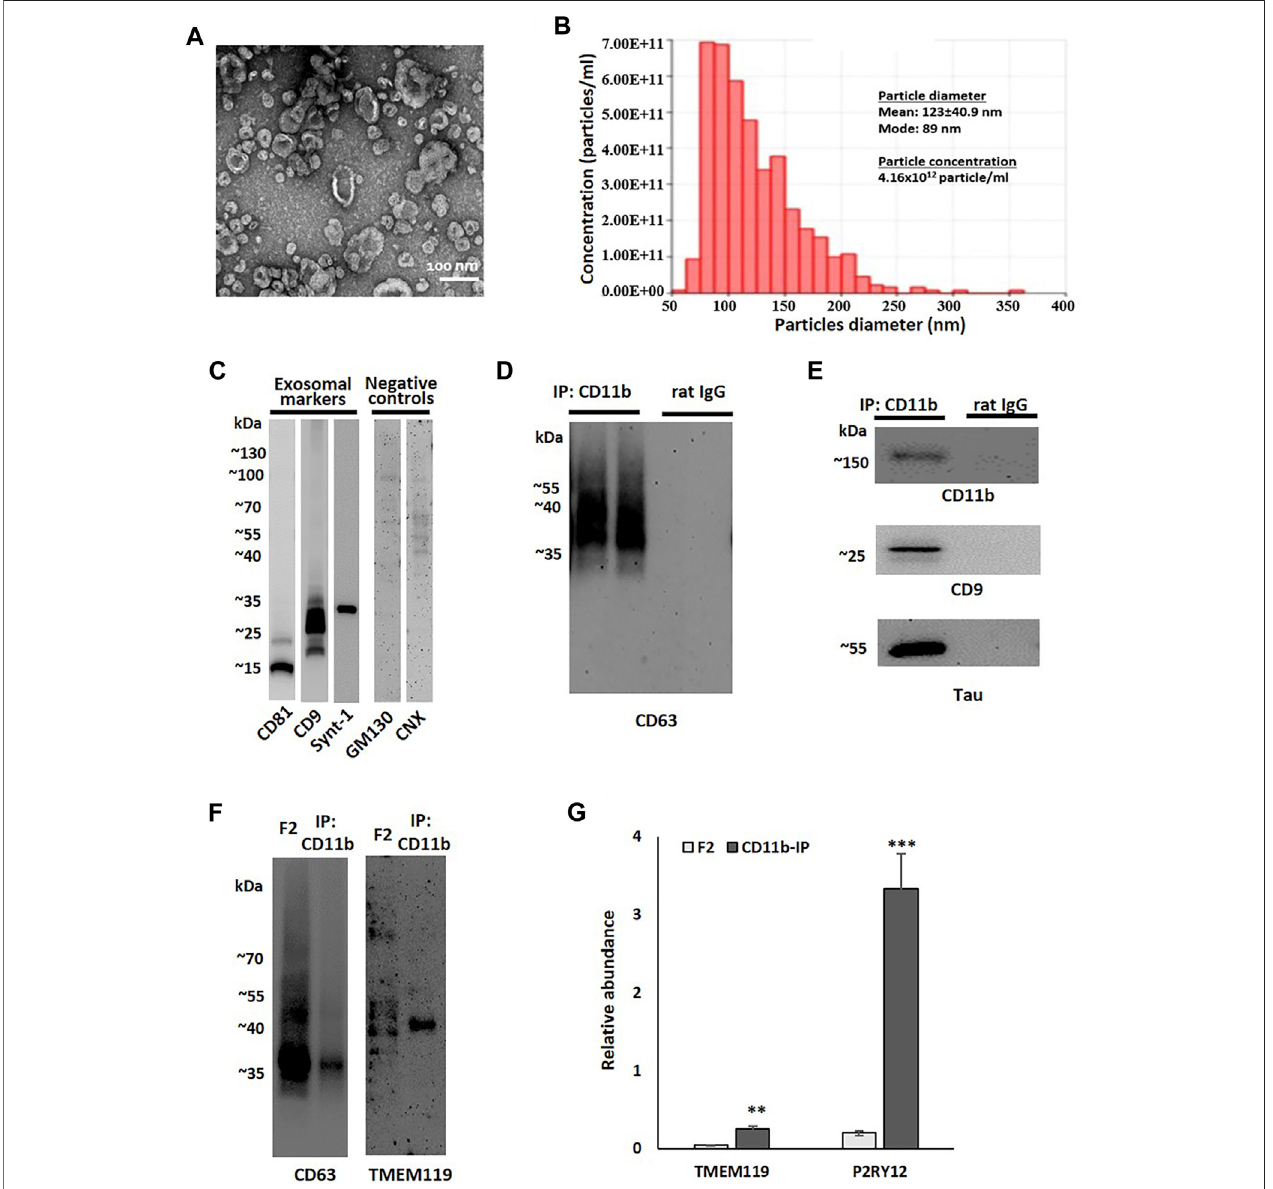
FIGURE1| Small EVfraction characterization and microglial EVpuri fi cation. (A) Representative transmission electron microscopy (TEM)image ofsmallEV fraction (F2) isolated from the human parietal cortex. (B) Tunable resistive pulse sensing (TRPS) analysis of the F2 fraction isolated from the human parietal cortex. (C) A representative image of immunoblot analysis of an F2 fraction using antibodies against exosomal markers (CD9, CD81, and syntenin-1) and negative control markers (GM130 and calnexin, CNX). (D) A representative image of immunoblot analysis of two immunoprecipitation (IP) samples pull-down either with antibodies against microglial marker CD11b or with corresponding isotype control antibodies (rat IgG2b). Membrane was probed with the exosomal marker CD63. (E) Immunoblotting of CD11b-IPsamplesand isotypecontrolsamplesprobed withantibodies against amicroglialmarker(CD11b),an exosomal marker(CD9),and tau. (F) Immunoblottingof the F2 fraction isolated from the human parietal cortex and corresponded CD11b-IP fraction with antibodies against the exosomal marker CD63 and the microglial markerTMEM119.ThesamplevolumewasequalbetweenCD63andTMEM119immunoblots. (G) Relativeabundancesofmicroglialmarkers,TMEM119andP2RY12, in F2 (n (cid:2) 6) and CD11b-IP samples (n (cid:2) 7) as indicated by LC-MS/MS (** p < 0.001; *** p < 0.0001).